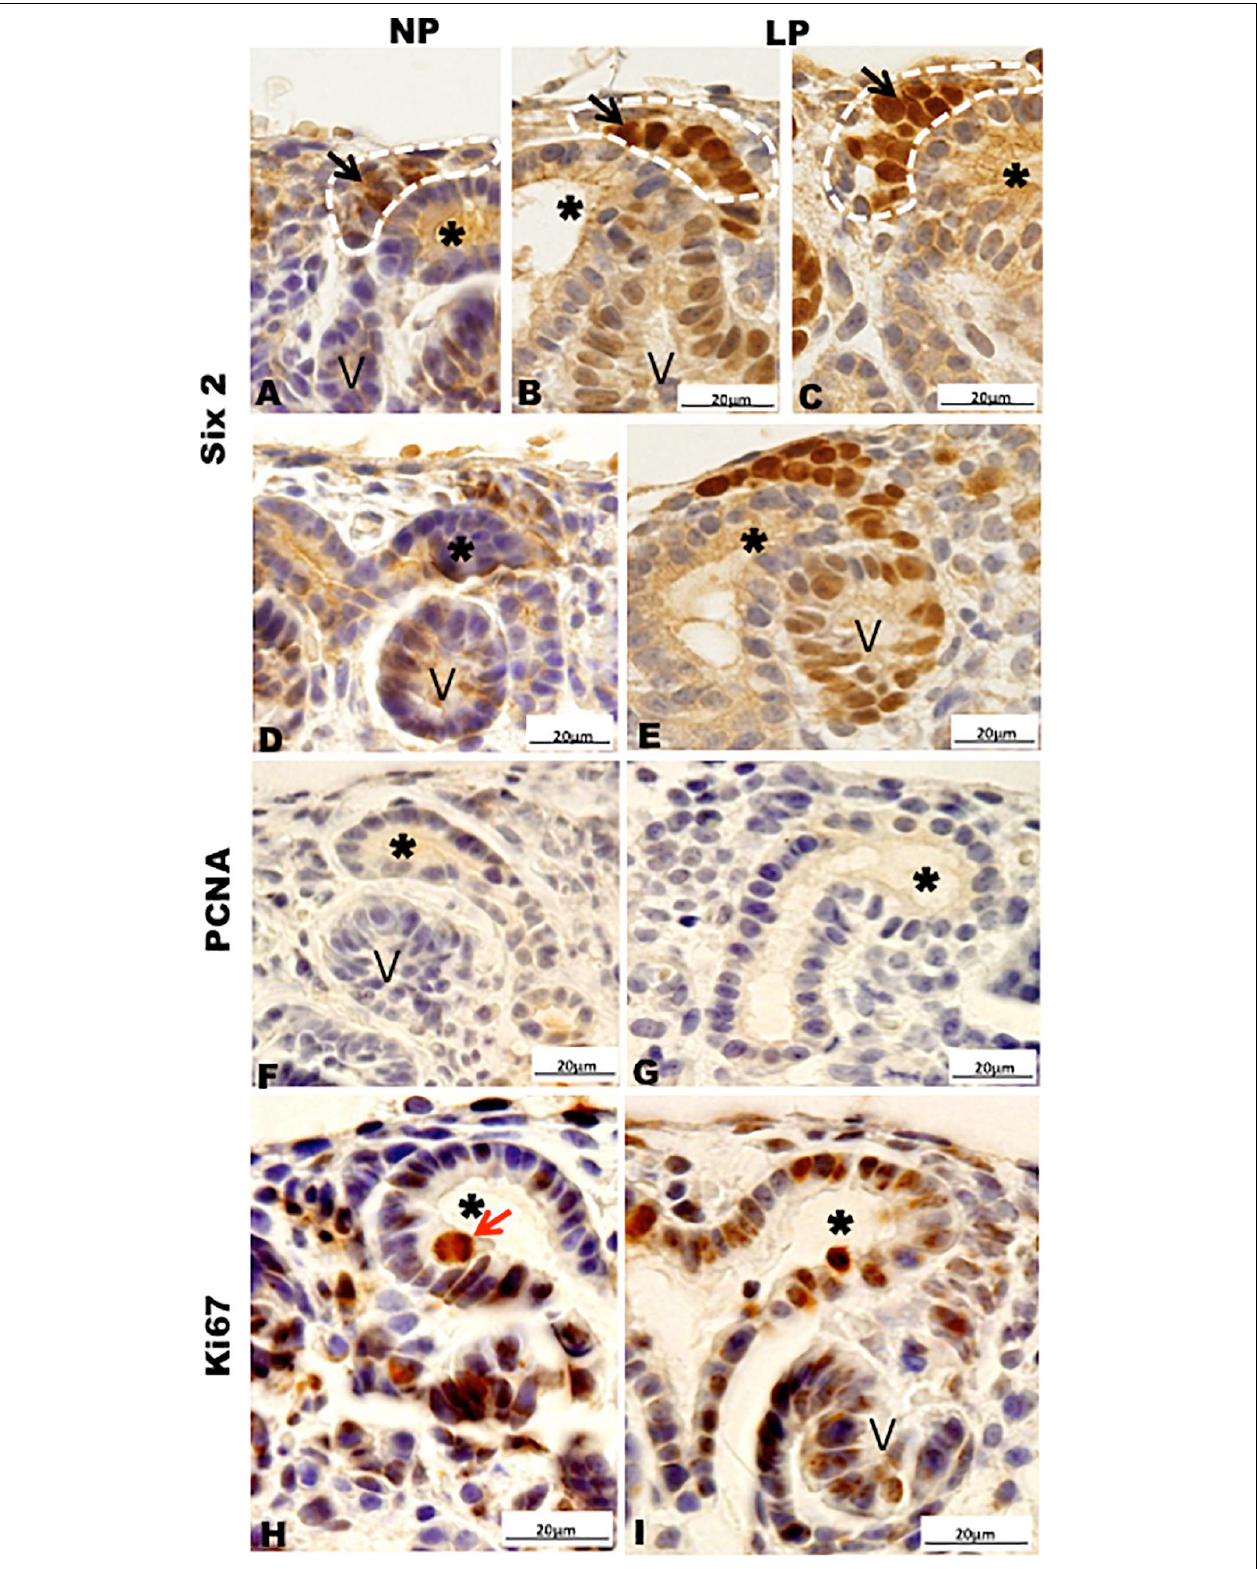
FIGURE 6 | Immunoperoxidase in kidneys of 21GD rats for (A–E) Six 2, (F,G) PCNA, (H,I) Ki67 for the NP (A,B,D,F,H) and LP (C,E,G,I) groups. CM (black arrow); UB (*) renal vesicles (V); cell in late anaphase (red arrow).